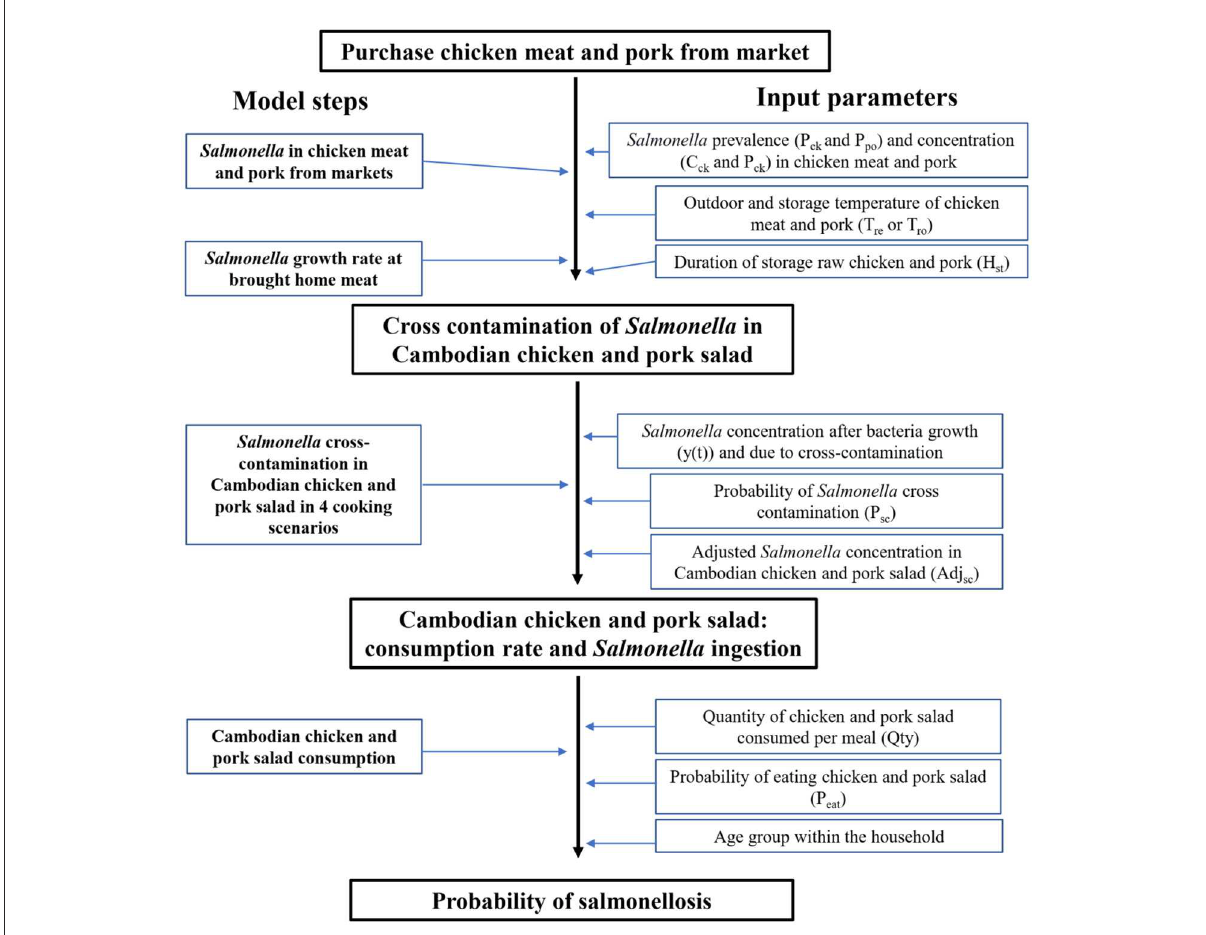
FIGURE1 Model steps and input parameters in Salmonella QMRA from market to household related to chicken and pork salad preparation and